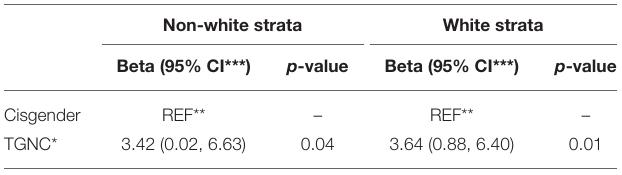
TABLE 3 | Univariable analysis of gender identity and mental health distress, stratified by race. Non-white strata